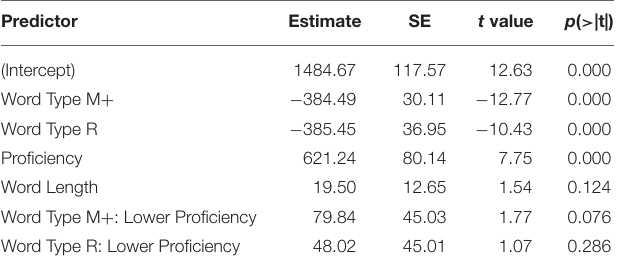
TABLE 6 | Mixed-effects model of response time in semantic relatedness judgment task.